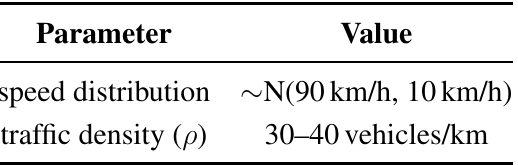
Table 4. Simulation settings for testing the forwarding